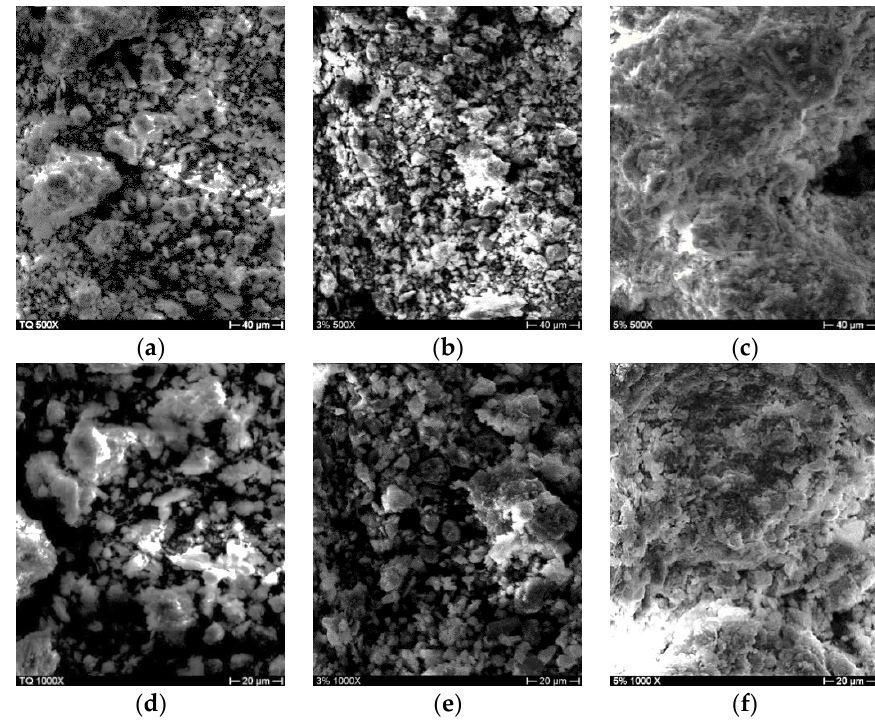
Figure 11. SEM images of ( a ) TQ0—500X; ( b ) TQ3 at 28 d mellowing period—500X; ( c ) TQ5 at 28 d mellowing period—500X; ( d ) TQ0—1000X; ( e ) TQ3 at 28 d mellowing period—1000X; ( f ) TQ5 at 28 d mellowing period—1000X.